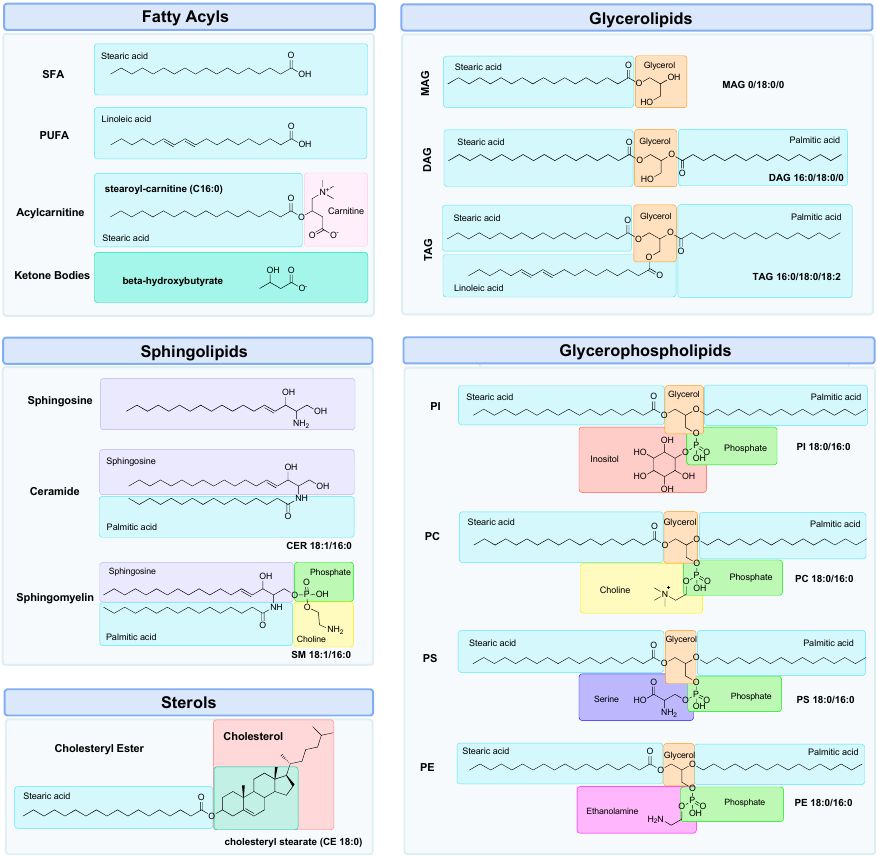
Figure 2. Different lipid classes most abundantly found in the brain. CE, cholesteryl ester; CER, ceramide; DAG, diacylglycerol; PC, phosphatidylcholine; PE, phosphatidylethanolamine; PI, phosphatidylinositol; PS, phosphatidylserine; MAG, monoacylglycerol; PUFA, polyunsaturated fatty acid; SFA, saturated fatty acid; SM, sphingomyelin; TAG,